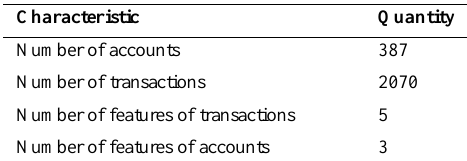
Figure 5. Pseudo-code of analyzing social network and extracting new feature phase in the proposed CAA method. Table 1. Characteristics of the dataset